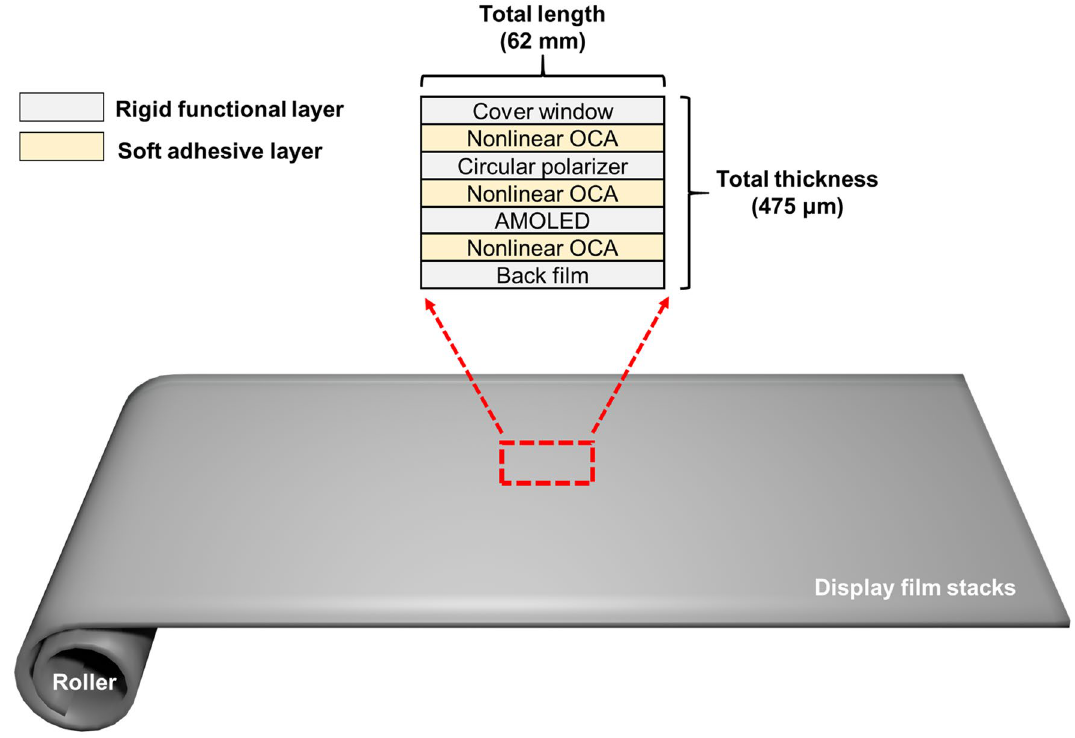
Figure 1. Schematic of Rollable display